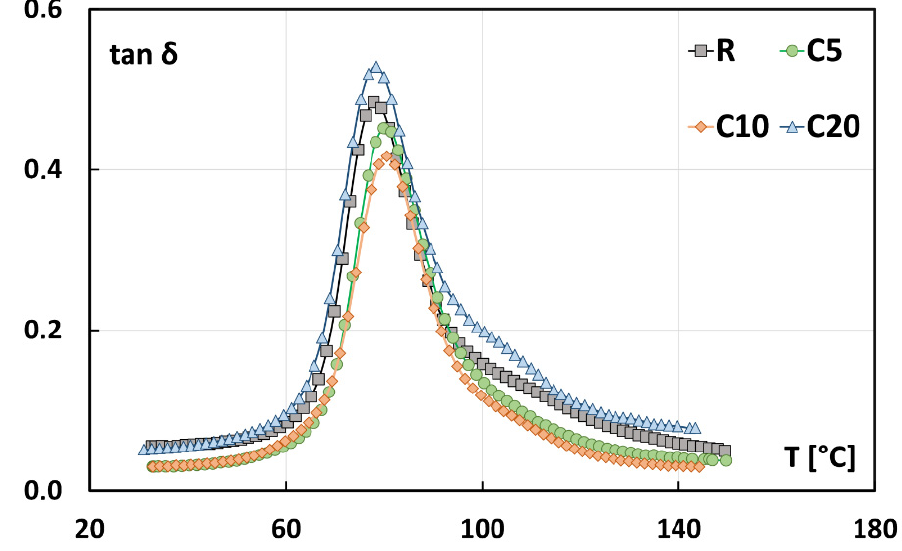
Figure 8. Typical tan δ trends of flax fiber reinforced composites.